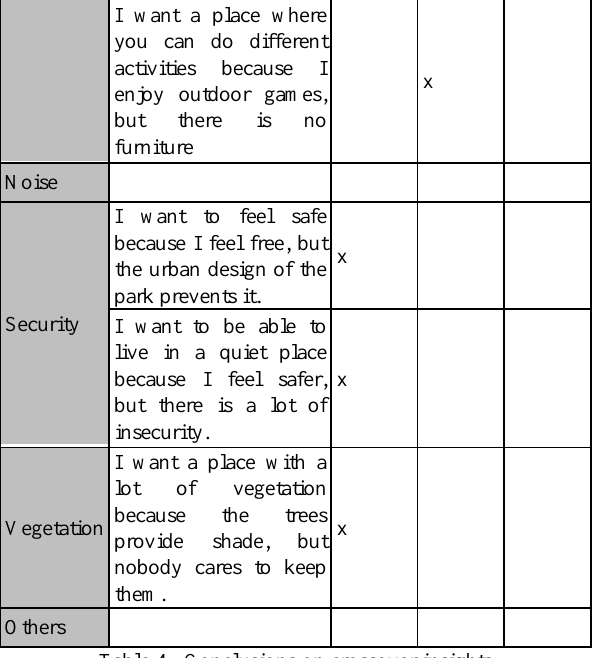
Table 4. Conclusions on crossover